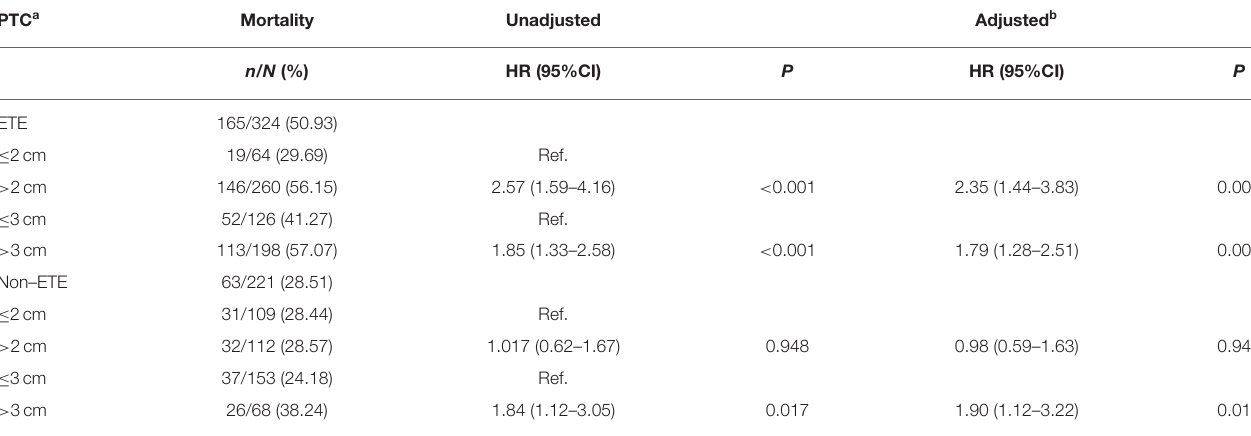
TABLE 5 | The threshold of tumor size concerning thyroid cancer specific mortality in papillary thyroid cancer patients with or without extrathyroidal extension (SEER database years of